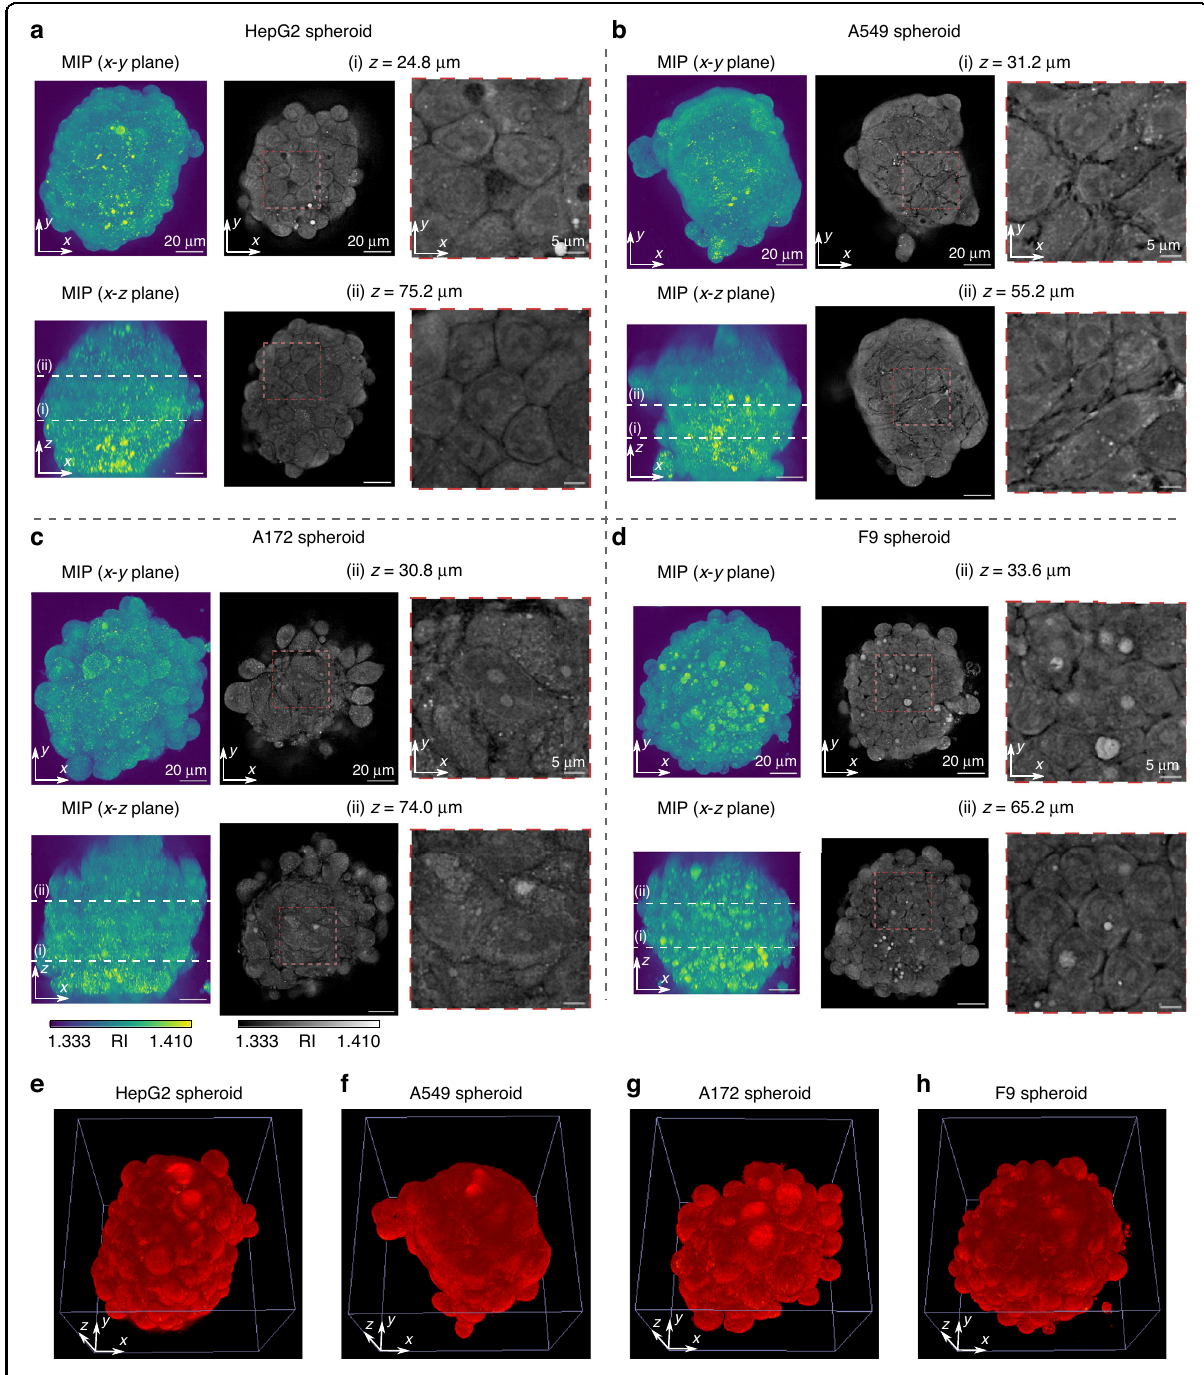
Fig. 4 RI tomography of various cell-type spheroids by in-silico clearing RI tomography. Maximum intensity projection (MIP) and cross- sections of RI maps for ( a ) HepG2, ( b ) A549, ( c ) A172, and ( d ) F9 spheroids. The depth of the cross-sections is denoted by white dashed lines in the MIP images; 3D rendering by alpha blending of RI distributions for ( e ) HepG2, ( f ) A549, ( g ) A172, and ( h ) F9 spheroids. The movies showing all cross- sections are provided in Supplementary Videos 2 and